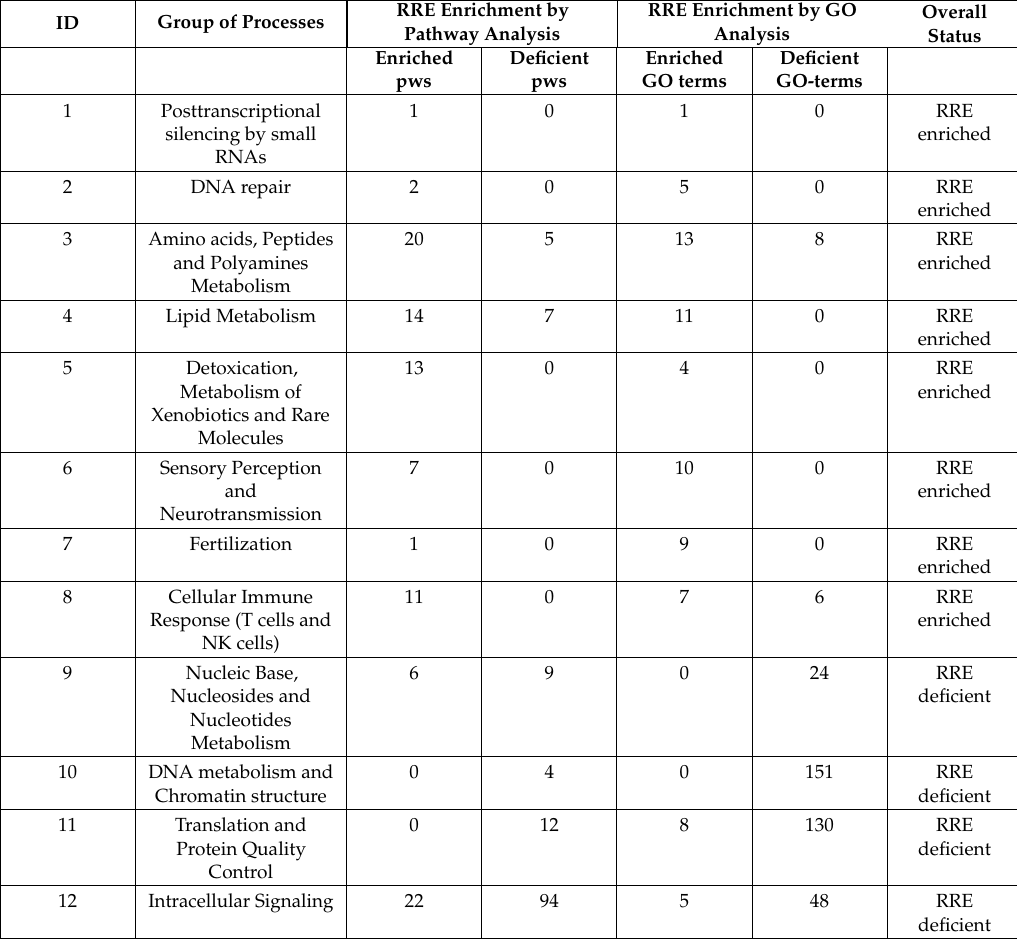
Table 3. RRE-enriched and deficient intracellular processes according to Gene Ontology (GO) and molecular pathway analysis ( all